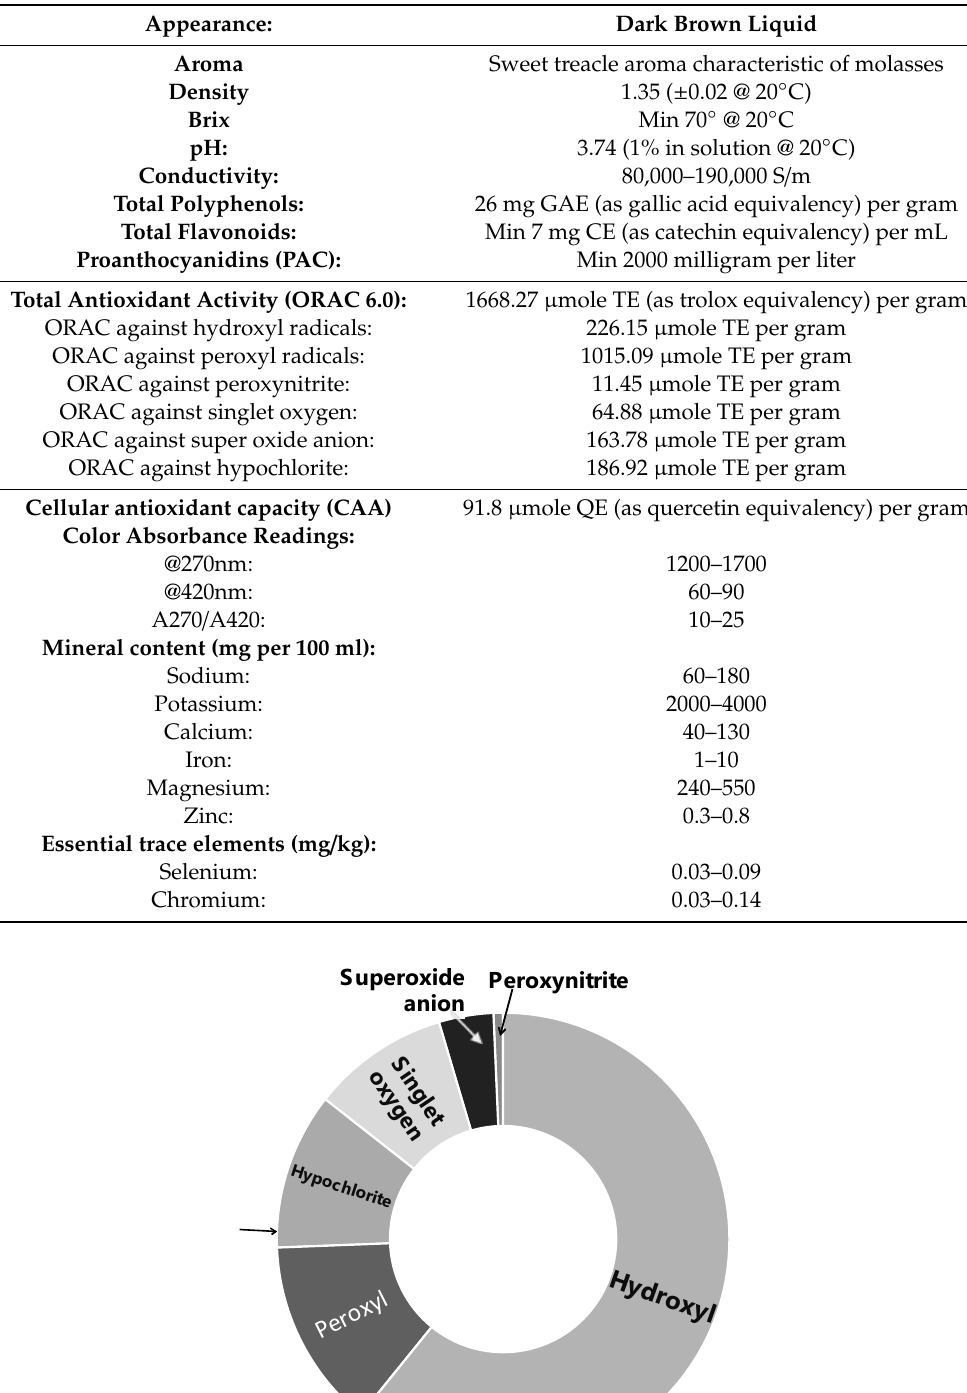
Table 1. Physical Properties of O ffi cinol ™ .